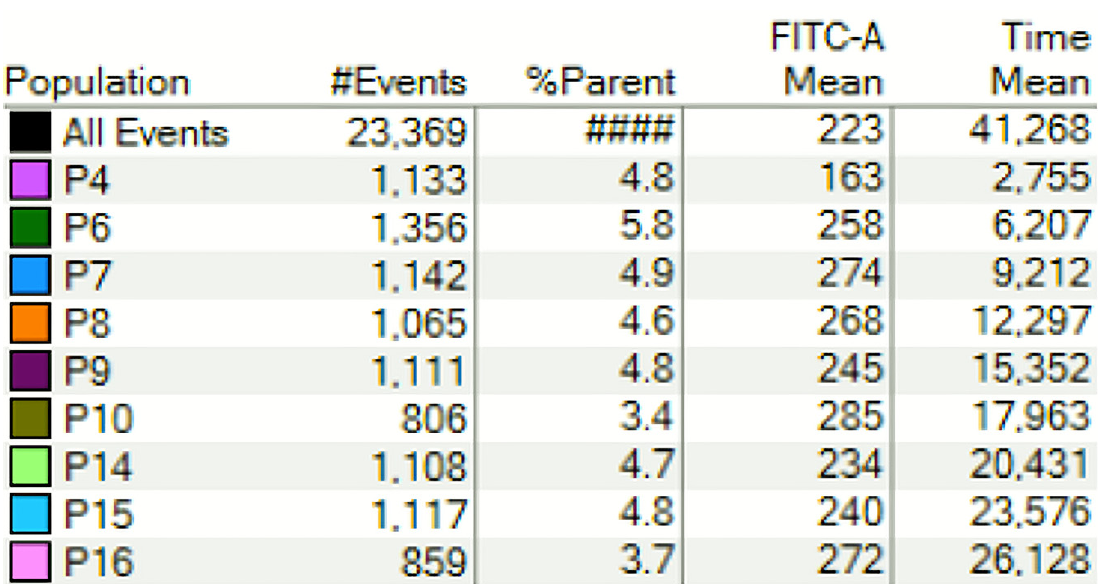
Figure 5. Evaluation of lipid peroxidation using BODIPY 665/676 C11. (a) Nasal epithelial cells were selected based on morphology and PI staining to exclude dead cells. ( b ) and ( c ) show the ratios of oxidised vs. reduced lipids.